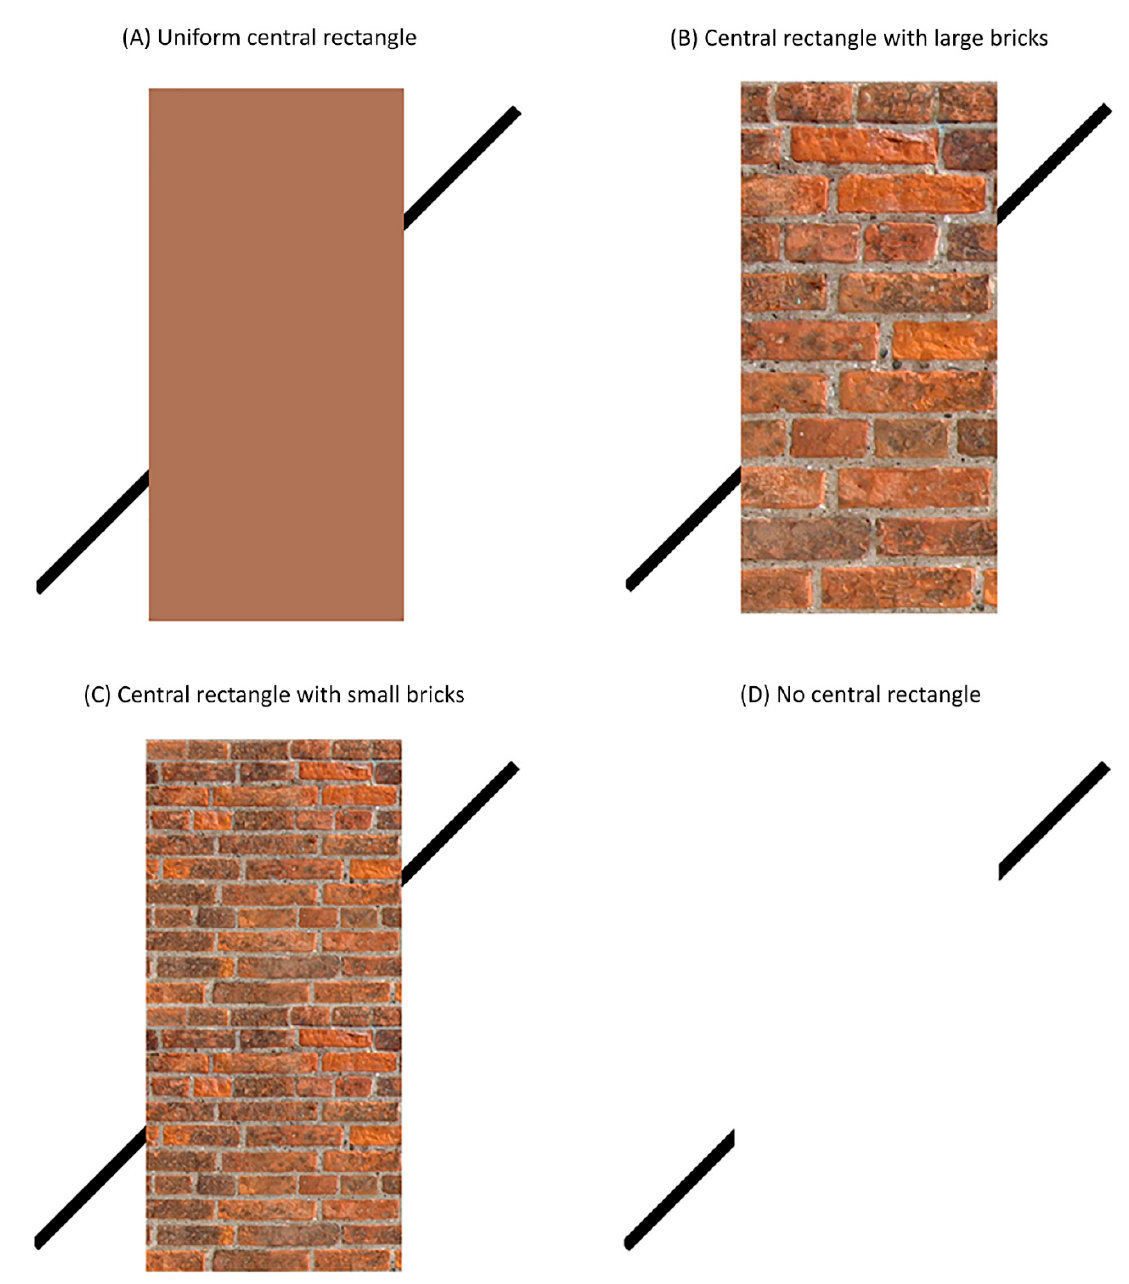
Figure 1. Poggendorff figures used to test for the effect of texture cues on the magnitude of the Poggendorff illusion in experiment 1. The Poggendorff stimuli consisted of ( A ) a uniform central rectangle, ( B ) a central rectangle with large bricks, ( C ) a central rectangle with small bricks and ( D ) no central rectangle. Similar central rectangles in ( A – C ) were used by Talasli and Inan